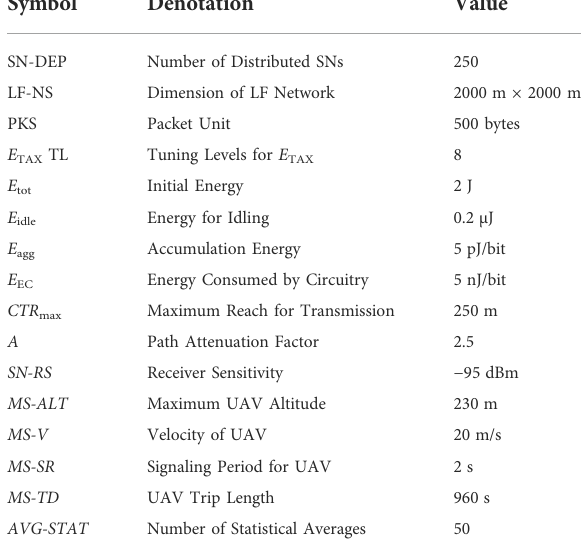
TABLE 4 Simulation speci fi cations.